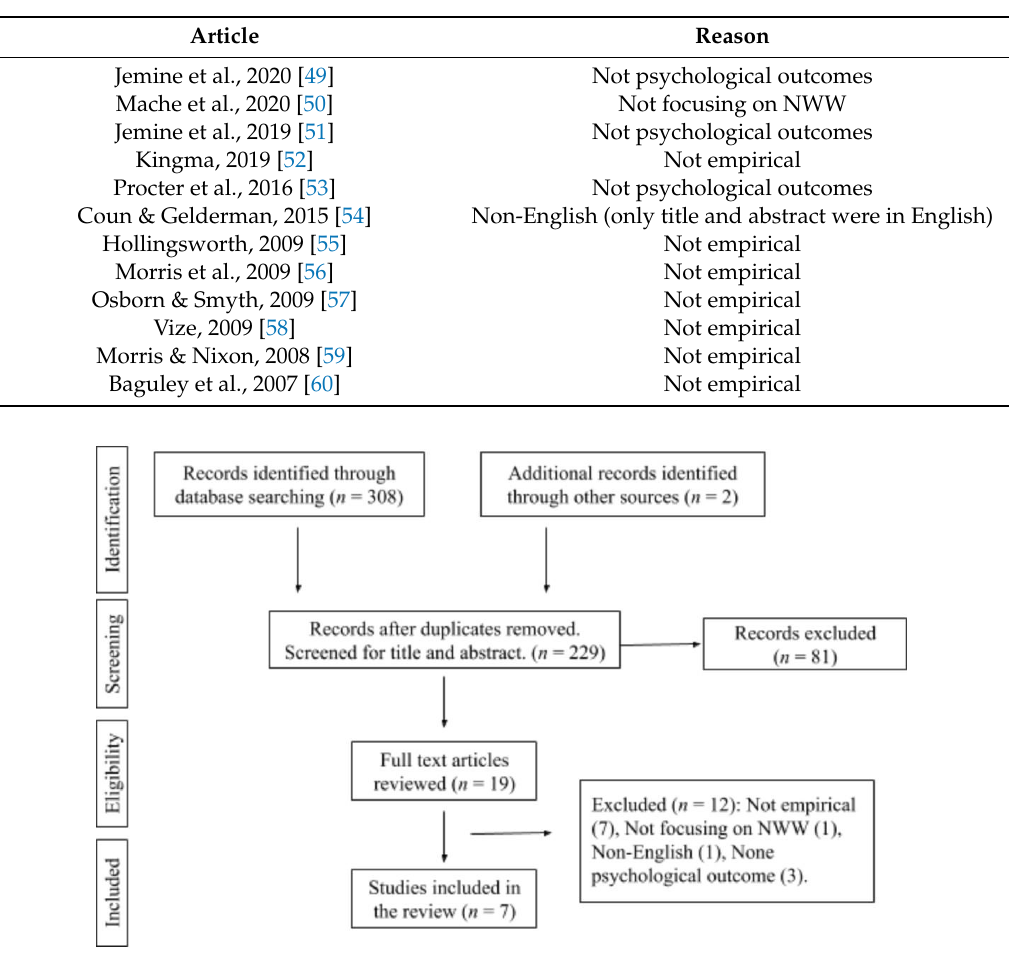
Figure 1. PRISMA flow diagram of the article selection process.